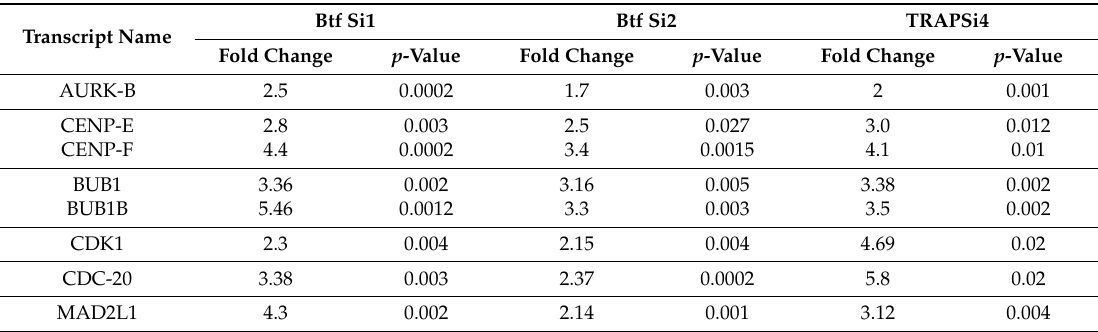
Table 1. Affymetrix HumanExon10ST Array results for differentially expressed major chromosomal passenger genes after Btf and TRAP150